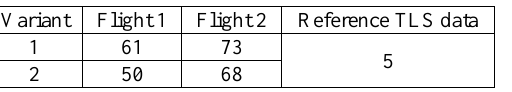
Table 3. Point cloud internal accuracy (RMSE [mm]) evaluated in two variants (description in the text).